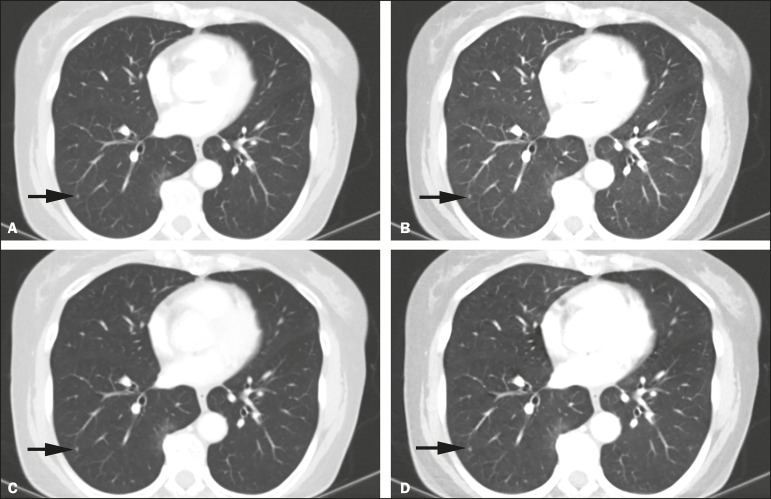
Contrast-enhanced DECT to investigate persistent cough in a 70
year-old-male (BMI = 25.9 kg/m2). Standard-of-care
monochromatic images at 60 keV (A) and 40 keV
(B) showing an indeterminate small nodule
(arrow) in the right lower lobe. Monochromatic images at 60 keV
(C) and 40 keV (D) from
reduceddose DECT showing the same nodule. Overall image quality
was considered optimal at both dose levels.